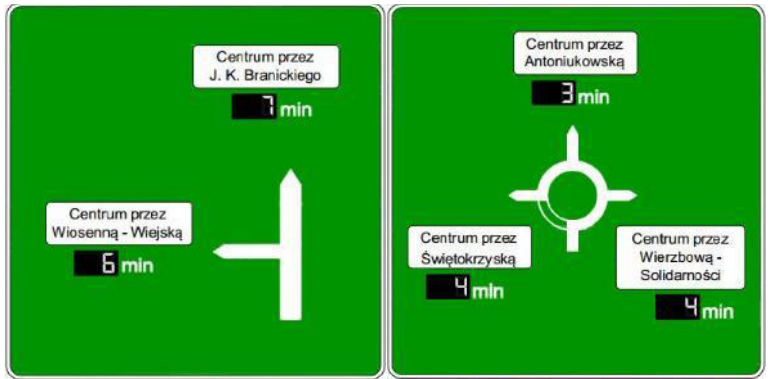
Figure 1. Structure and travel time information (TTI) displayed on the investigated variable message signs (VMS).